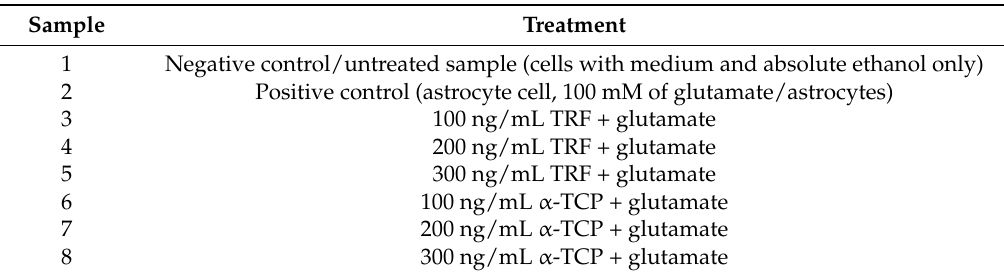
Table 1. Experimental design of vitamin E treatments against glutamate injury.